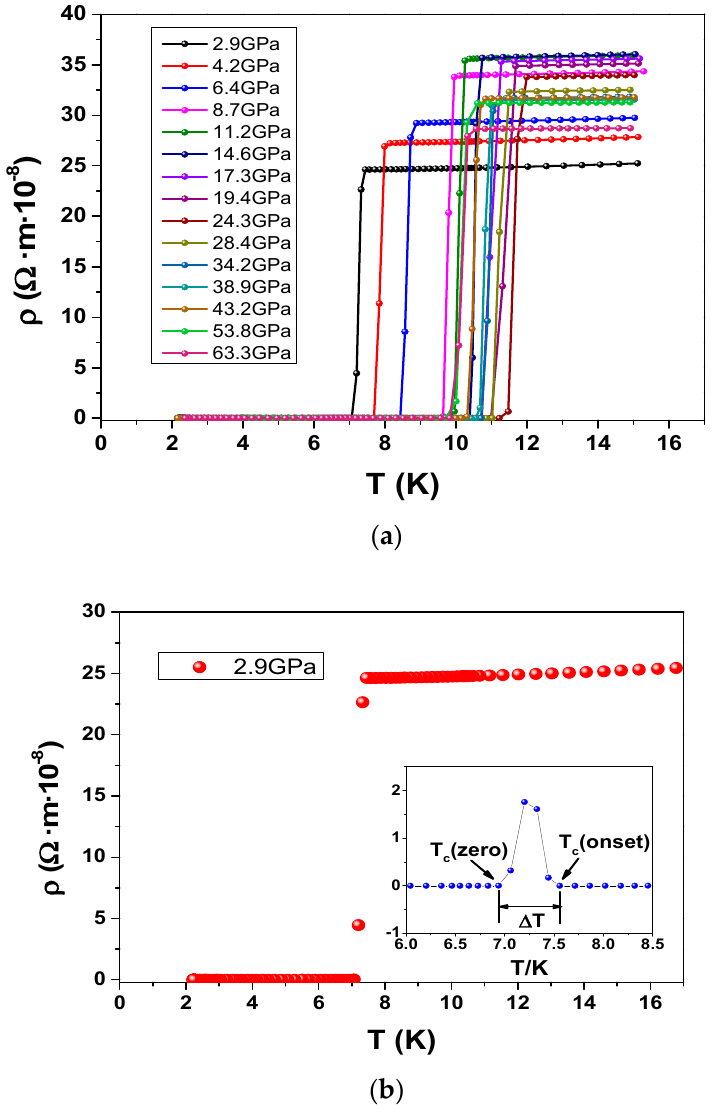
Figure 3. ( a ) Superconducting transition of La at various pressures, showing sharp superconducting transitions; ( b ) superconducting transition width ∆ Tc in terms of the width between T c onset versus T c zero , which can be well defined from the derivative of resistivity with temperature, as shown in the inset.